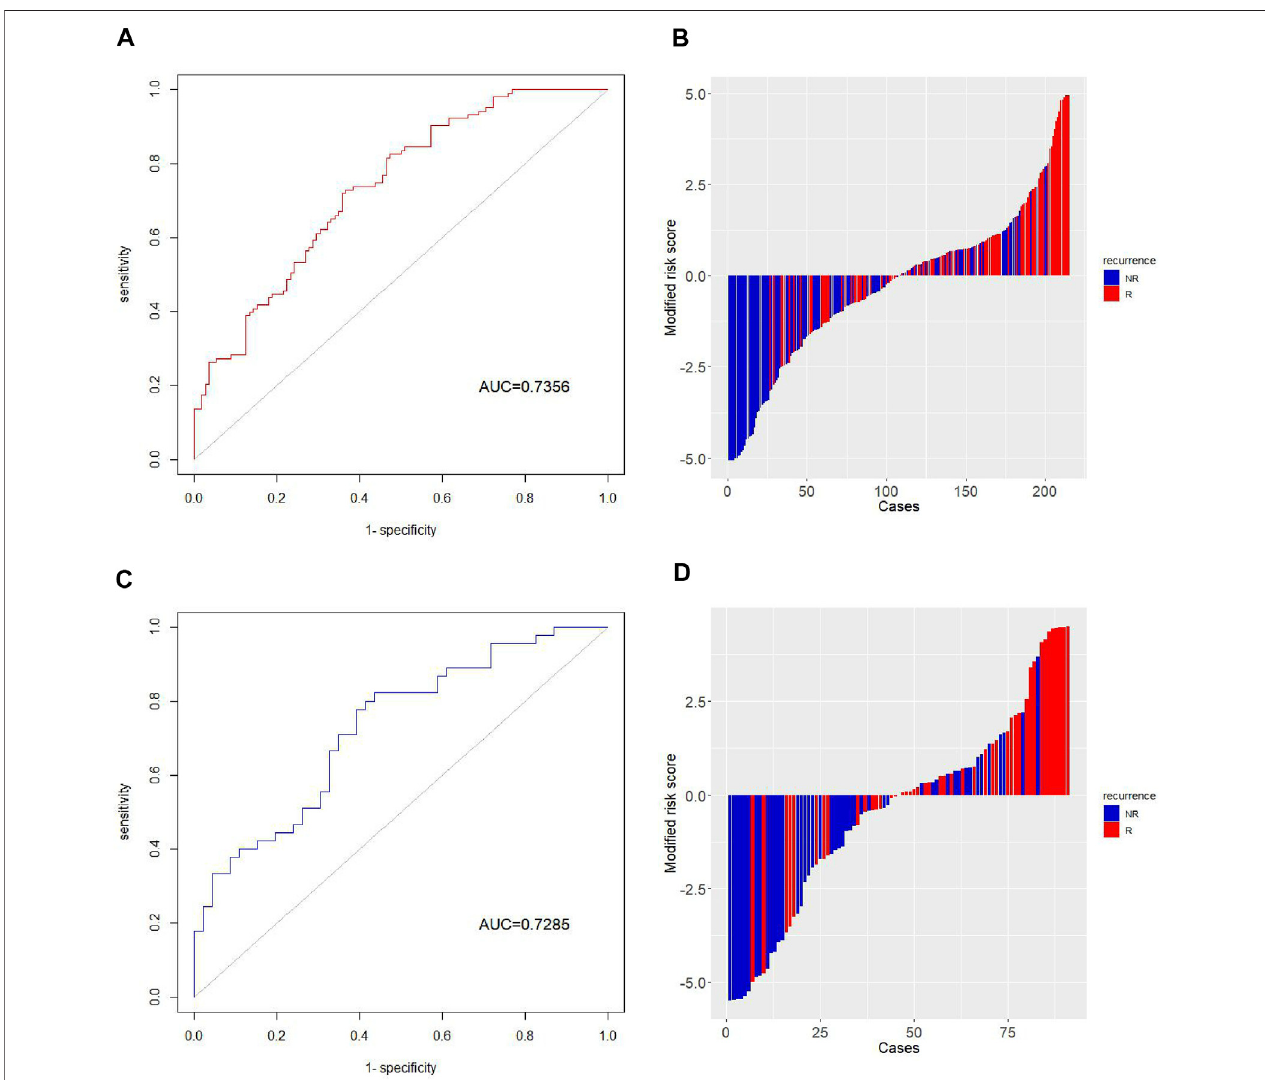
FIGURE 5 | Performance evaluation of the risk assessment model.The ROC curves demonstrate the diagnostic performance of the model in distinguishing recurrent patients in the (A) training cohort and (C) validation cohort. The histograms show the risk score distribution in the (B) training and (D) validation cohorts. For convenience of display, the risk score is subtracted from the median and magni fi ed 10 times to obtain the modi fi ed risk score.